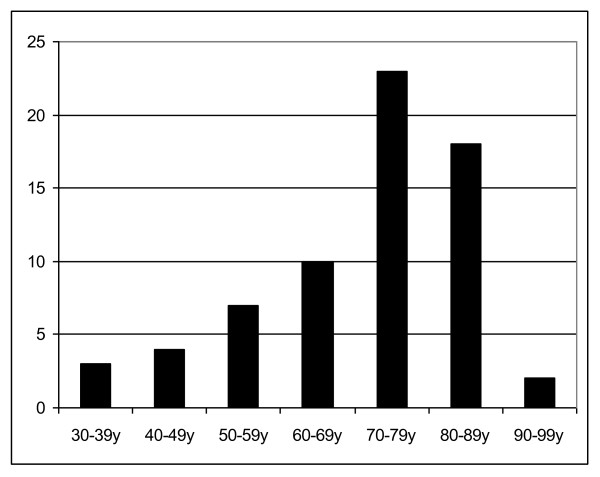
Age distribution.